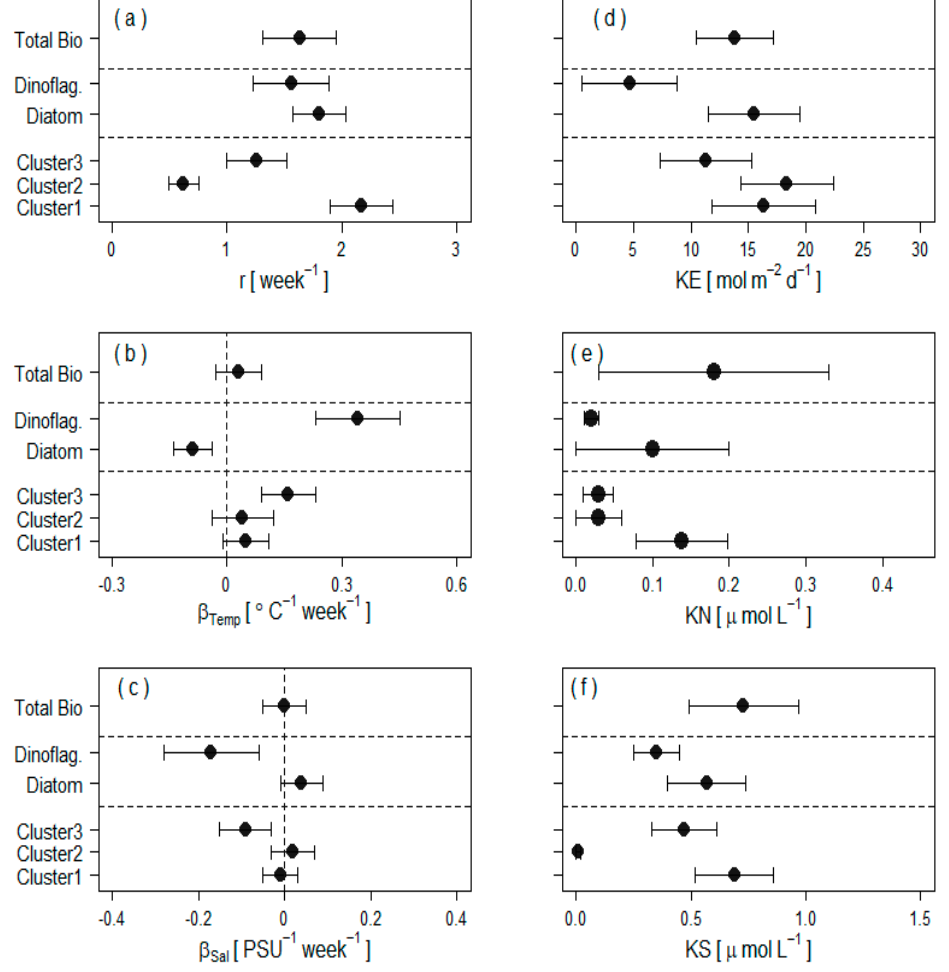
Figure 4. Estimated trait values for three different clustering schemes (total biomass, top; functional type clustering, middle; trait-based clustering, bottom) showing: ( a ) intrinsic growth rates; ( b ) temperature effect on growth rate; ( c ) salinity effect on the growth rate; ( d ) irradiance half-saturation constant; ( e ) nitrogen half-saturation constant; and ( f ) silicate half-saturation constant for each cluster of species. Error-bars (posterior mean ± 1 SD) represent 68% credible intervals around the posterior means (filled circles). These results are based on independent N + ( 15, 20 ) priors on cluster-specific irradiance half-saturation constants under our three clustering schemes.